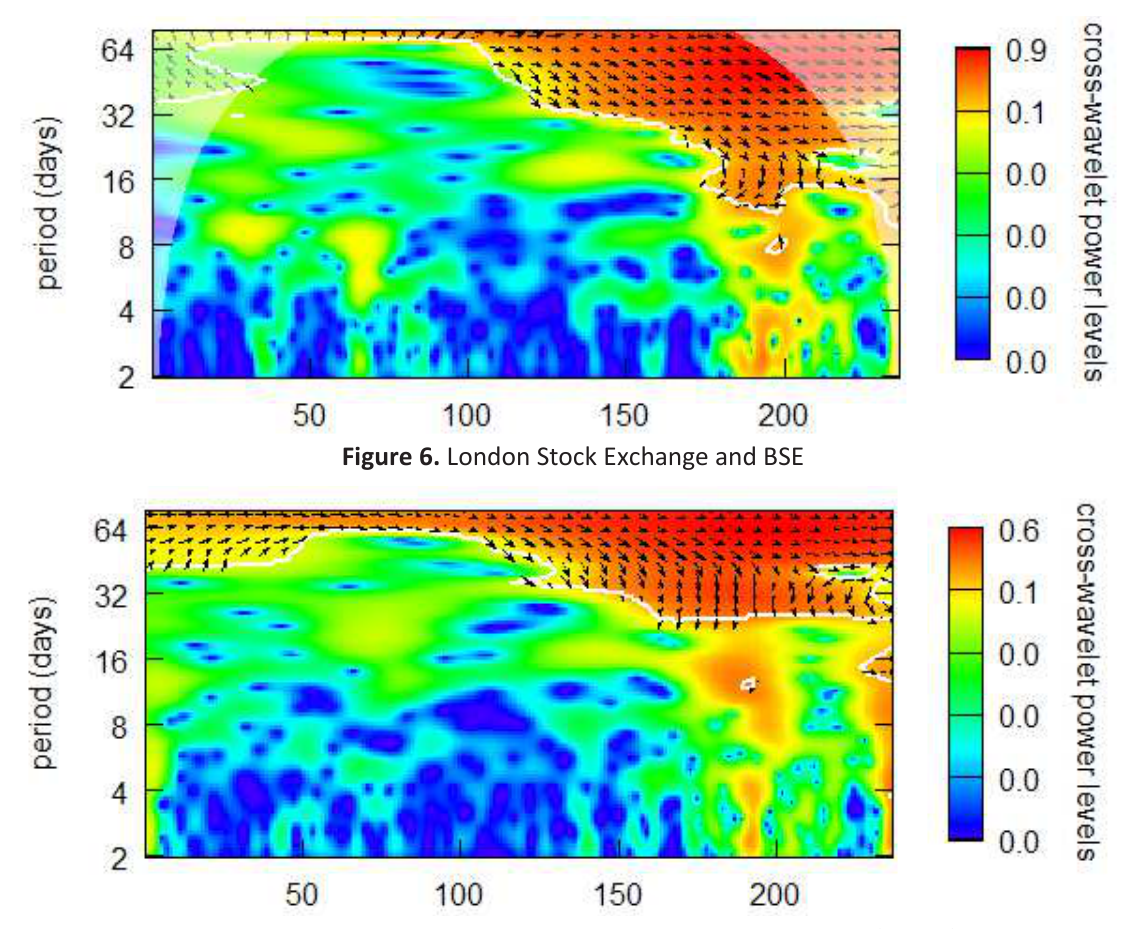
Figure 7. Shanghai Stock Exchange and Tokyo Stock Exchange